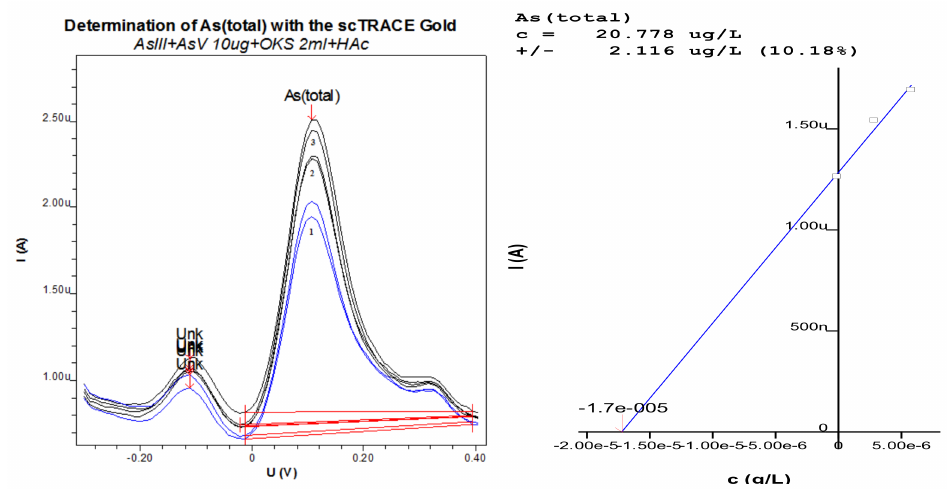
Figure 2. Voltammograms for As(tot) in As(III)/As(V) model solution ( γ = 10 µ g L − 1 ) with addition of OX (c(OX) = 2 × 10 − 3 mol L − 1 and HAc solution (1); (2) after first addition of 50 µ L As(V) standard solution (c = 1 × 10 − 3 mol L − 1 ); (3) after second addition of the same standard solution and corresponding analytical